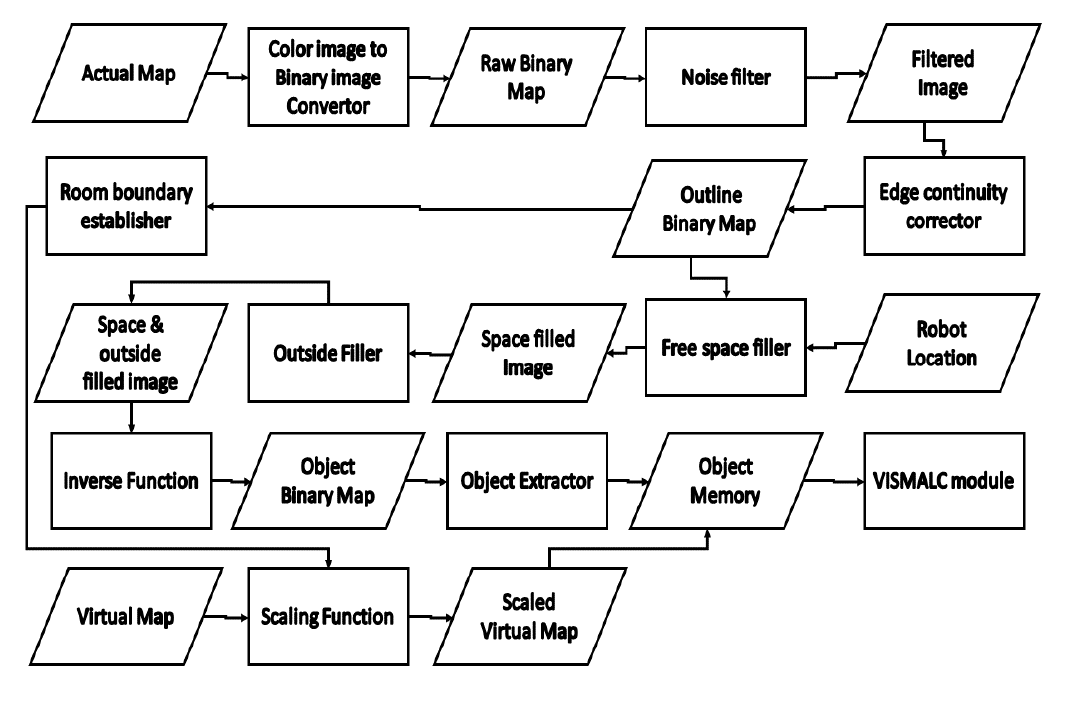
Figure 2: Process flow of a spatial